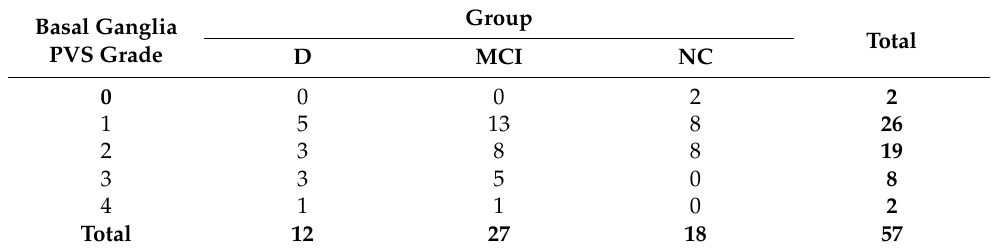
Table 2. Basal Ganglia PVS dilatation grade in dementia, MCI and normal cognition groups.